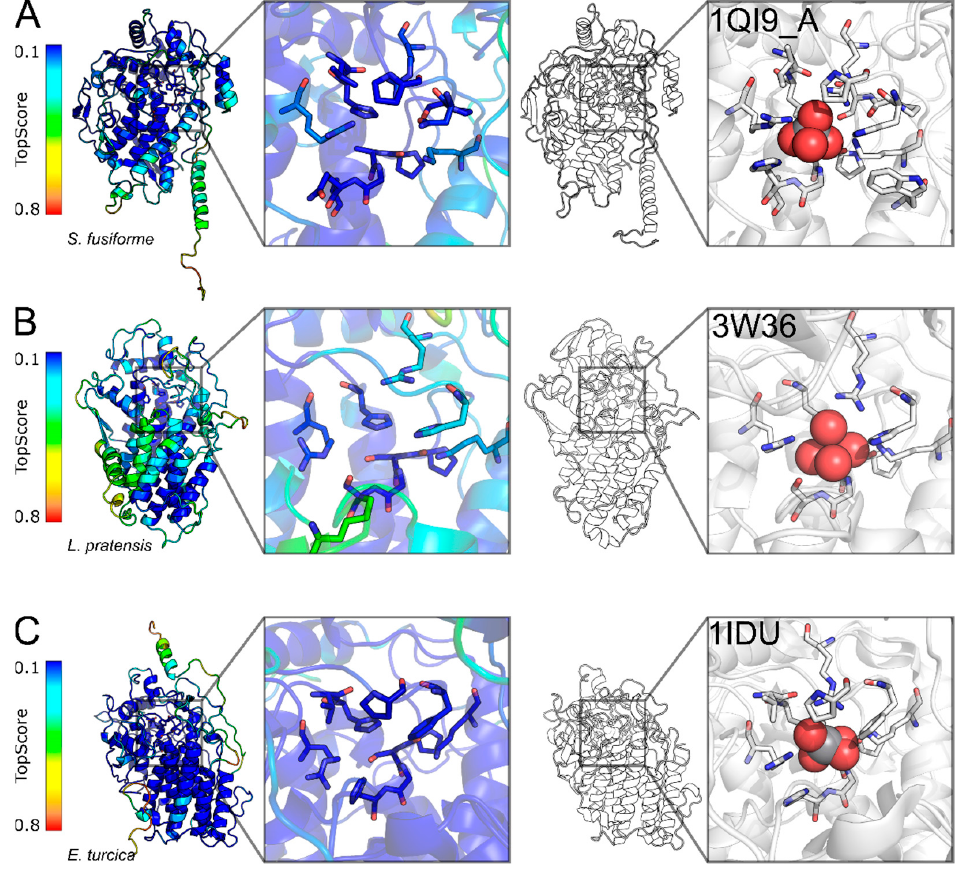
Figure 3. Examples of high-quality structural models of haloperoxidases. One example for each taxonomic group is reported with Sargassum fusiforme for algae ( A ), Luteitalea pratensis for bacteria ( B ), and Exserohilum turcica for fungi ( C ). The local quality of the models is assessed with TopScore where darker blue color indicates better quality ( left ). The best template selected for each example is also reported for comparison as white colored structure ( right ). The vanadium cofactor is shown as spheres and residues located ≤ 5 Å from it are reported as